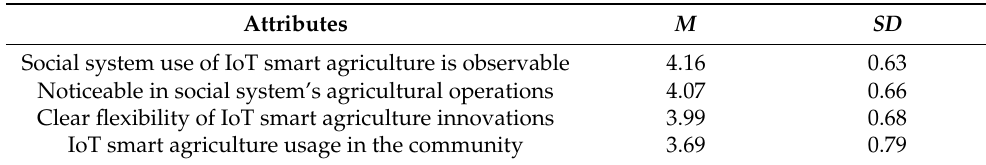
Table 7. Visibility’s Innovation Metrics ( n =